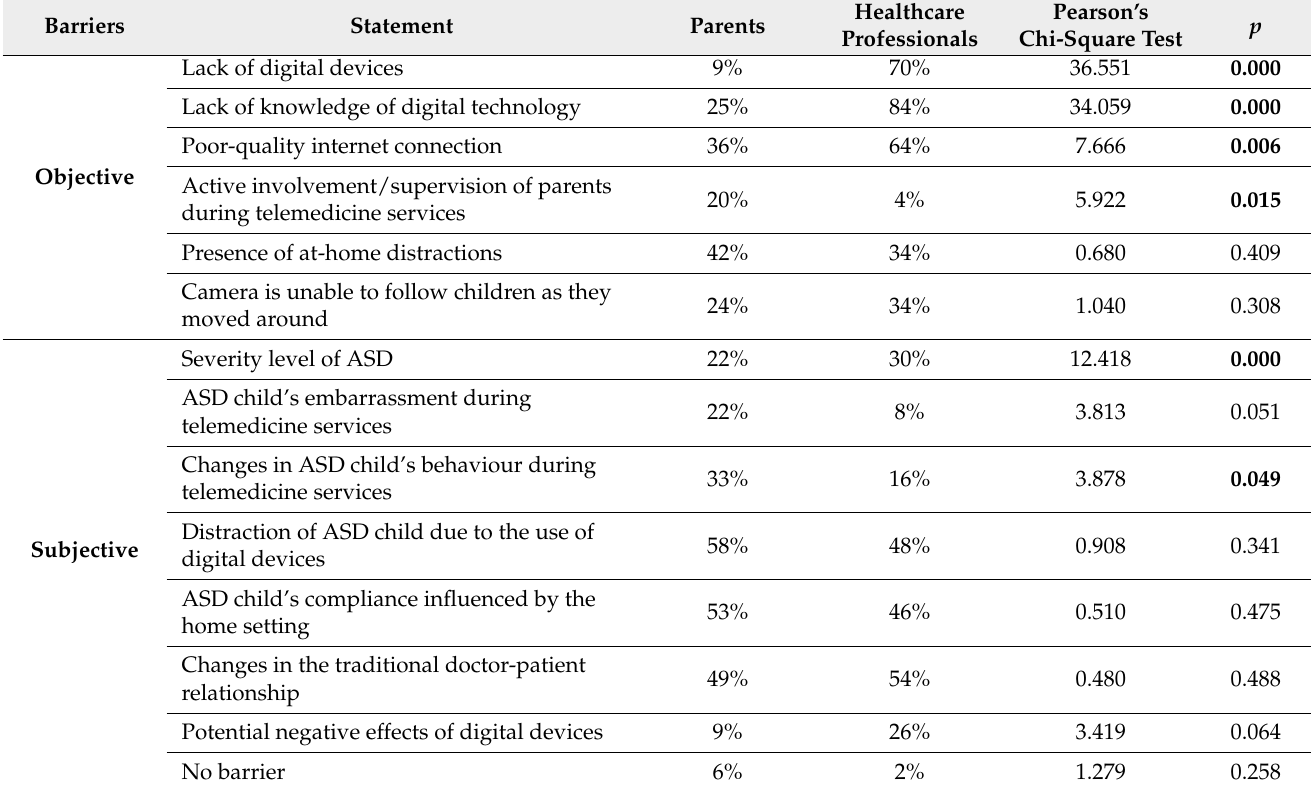
Table 4. Comparison of parents’ and professionals’ answers on the second section of Telemedicine Expectations Questionnaire: Concerns about objective and subjective